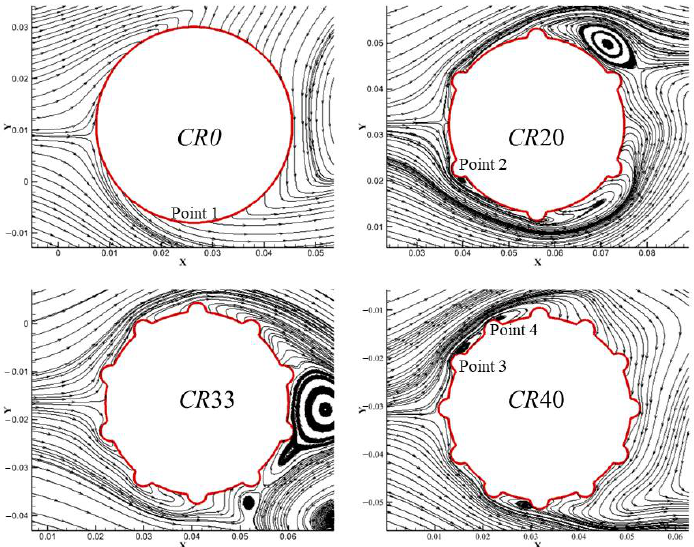
Figure 20. Close-up of the streamlines of a cylinder with different coverage ratios at U ∗ = 11. Figure 21 is the vorticity contours for a cylinder with different coverage ratios at selected reduced velocities. In all frames, the cylinder is located at its maximum value. With